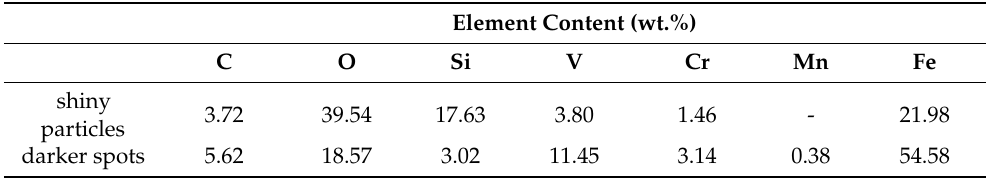
Table 6. EDS analyses in selected areas of the